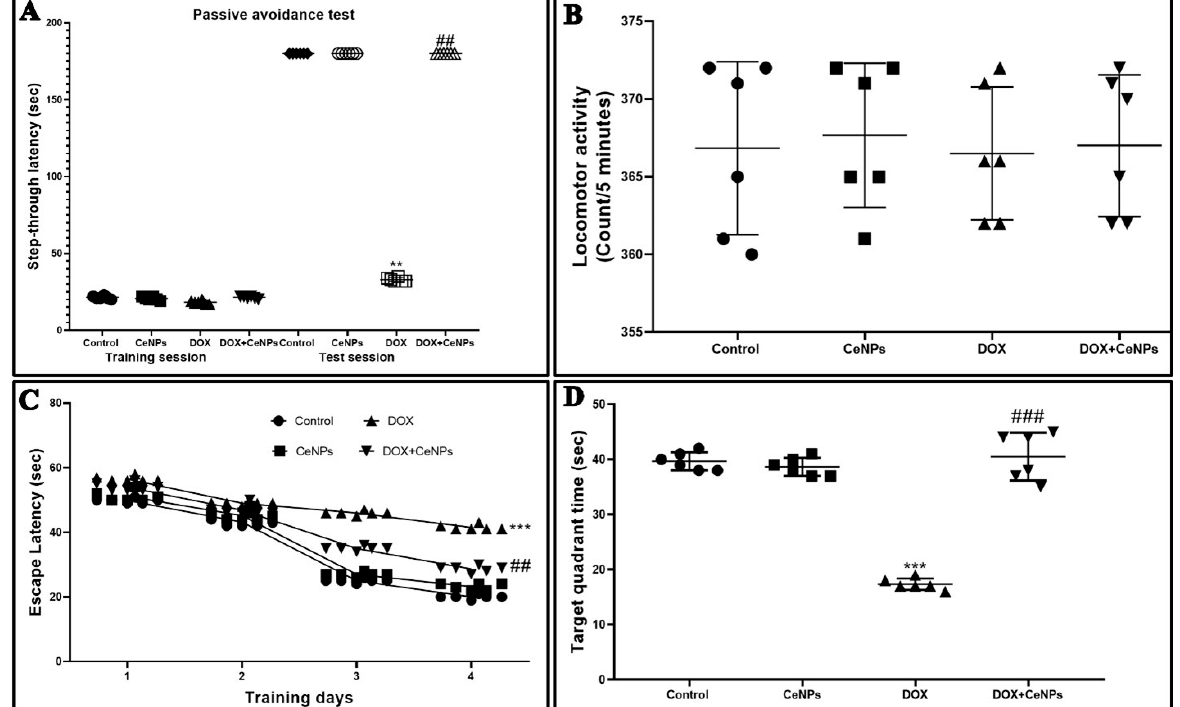
Figure 1. Effect of nanoceria treatment on DOX ‐ induced behavioral changes: ( A ) Step ‐ through passive avoidance for the training session and test session. ( B ) Locomotor activity. No significant